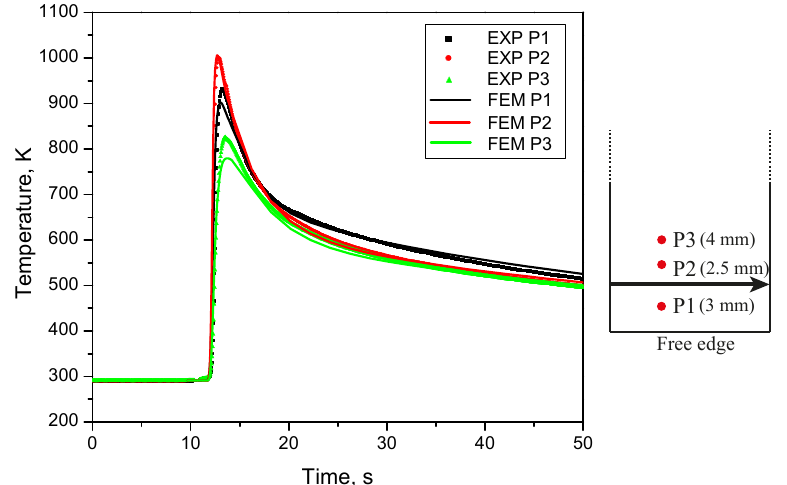
Figure 6. Experimental and calculated temperature cycles for the 13 mm case. The position of the points P1, P2 and P3 with respect to the weld centerline is also indicated. P1 is at a distance of 3mm (towards free edge), while P2 and P3 are at 2.5mm and 4mm (towards the fixed